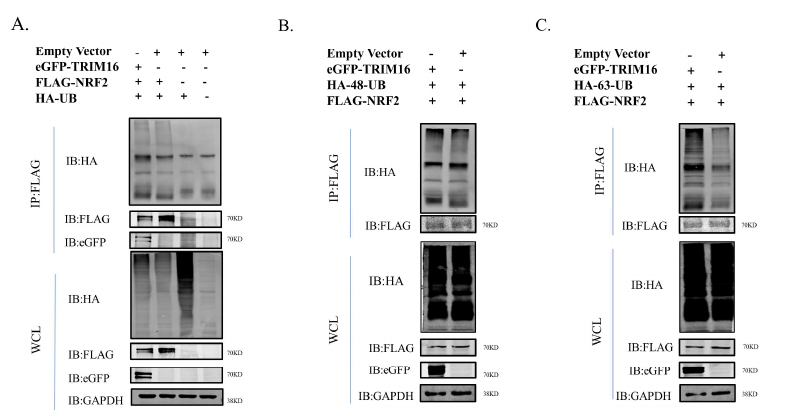
Figure 7. TRIM16 increases K63-linked poly-ubiquitination of NRF2. ( A ) HEK 293T cells were transfected with PCAGGS-FLAG-NRF2, HA-UB expression plasmids, PCAGGS-eGFP-TRIM16 or PCAGGS empty vector. ( B ) HEK 293T cells were transfected with PCAGGS-FLAG-NRF2, PCAGGS-eGFP-TRIM16 expression plasmids, HA-K48-UB or PCAGGS empty vector. ( C ) HEK 293T cells were transfected with PCAGGS-FLAG-NRF2, PCAGGS-eGFP-TRIM16 expression plasmids, HA- K63-UB or PCAGGS empty vector. GAPDH was used as loading control.